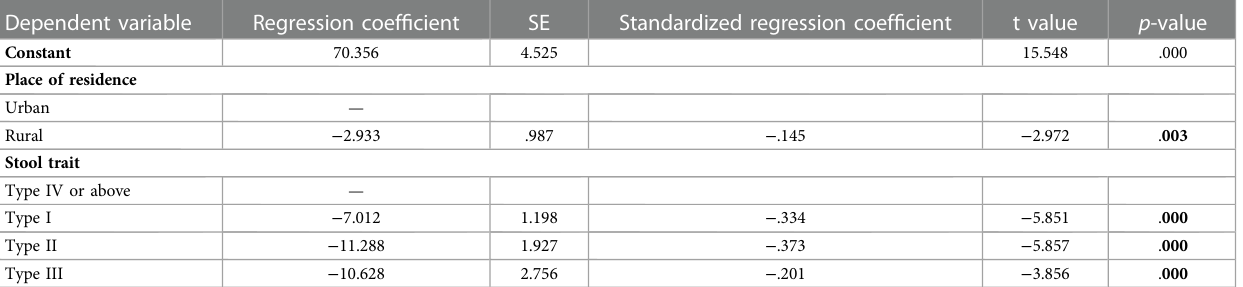
TABLE 6 Regression analysis of multiple factors in nursing needs ( N =211).